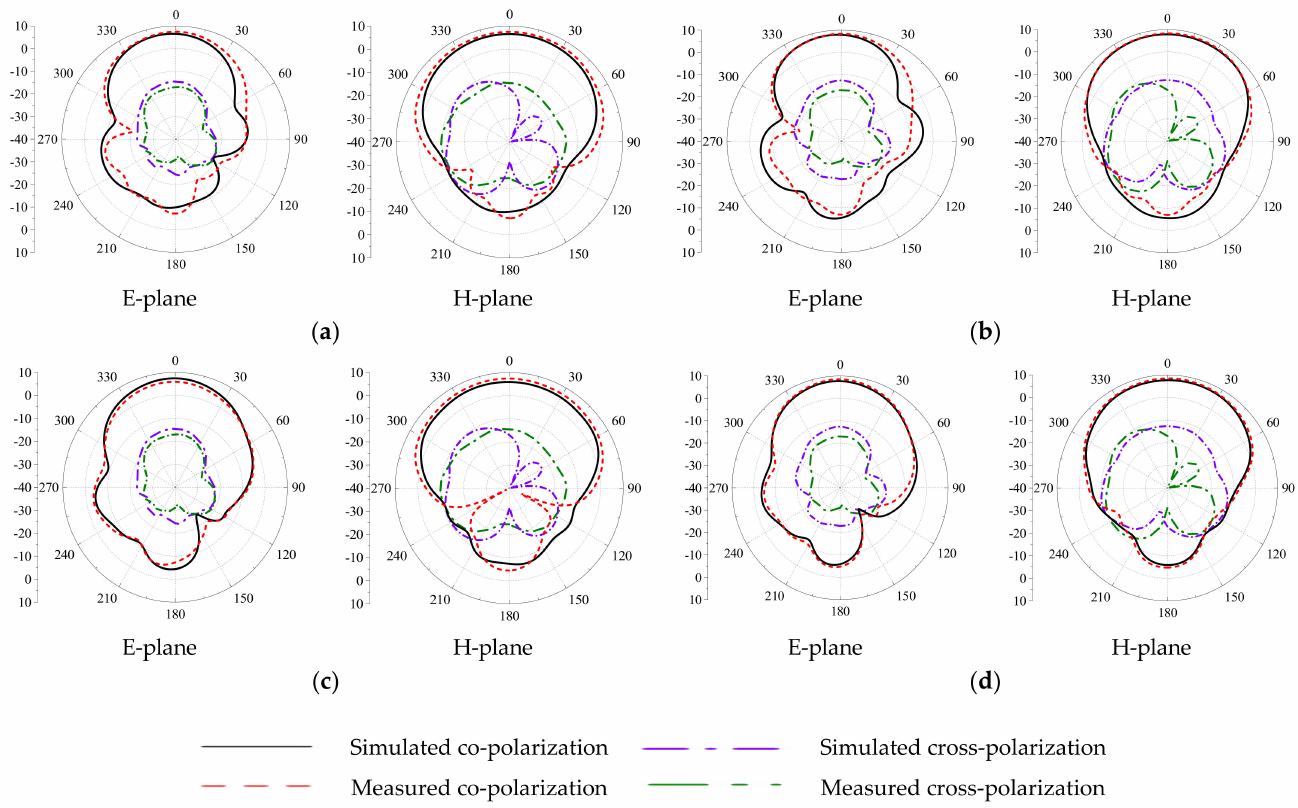
Figure 11. Measured and simulated radiation patterns of the TSA with and without dielectric lens (DL) on the E-plane (left side) and H-plane (right side), ( a ) without DL and ( b ) with DL at 10 GHz; and ( c ) without DL and ( d ) with DL at 11